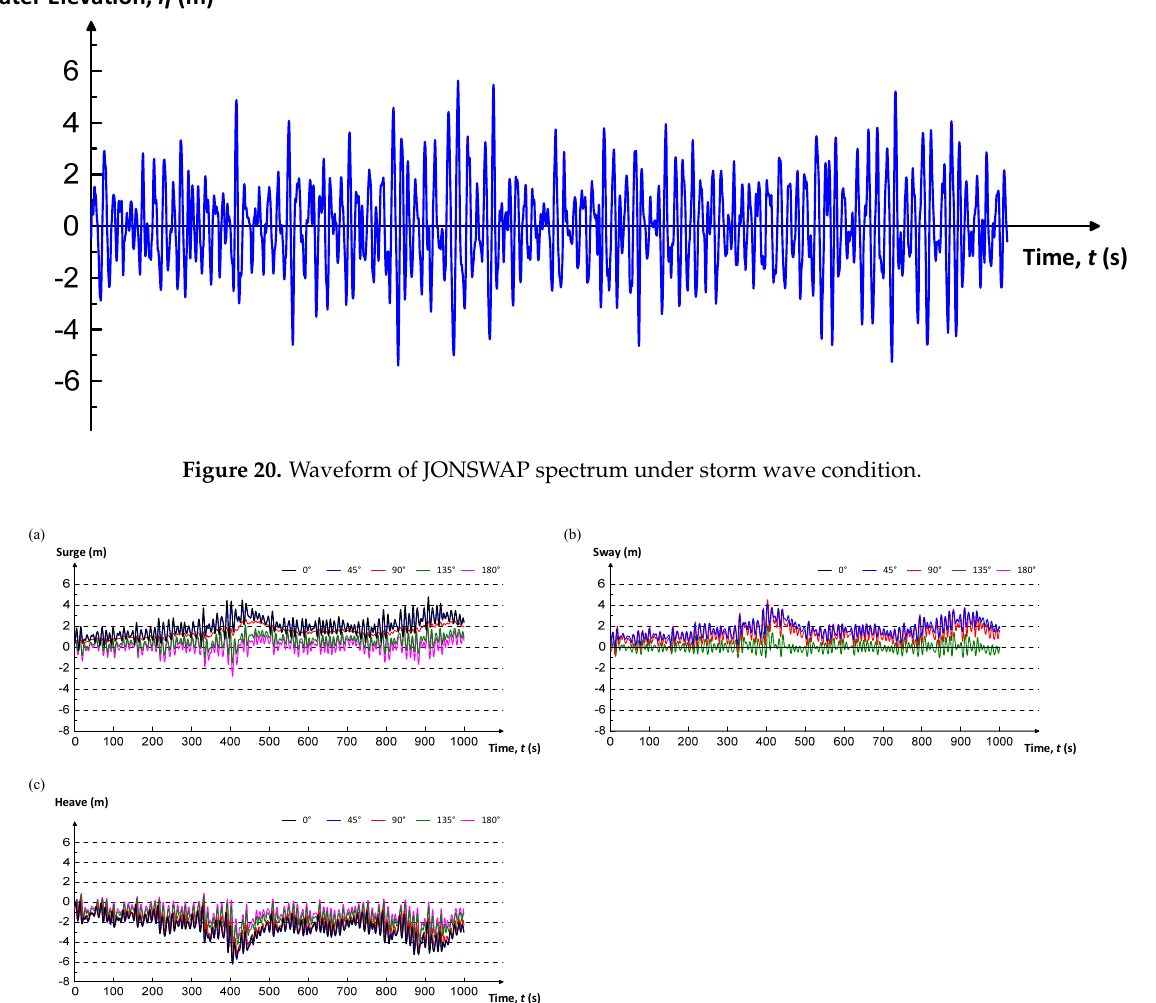
Figure 21. Translational responses against different approaching wave directions under storm wave conditions. ( a ) Surge; ( b ) Sway; ( c ) Heave. Duct is 25 m below sea surface.